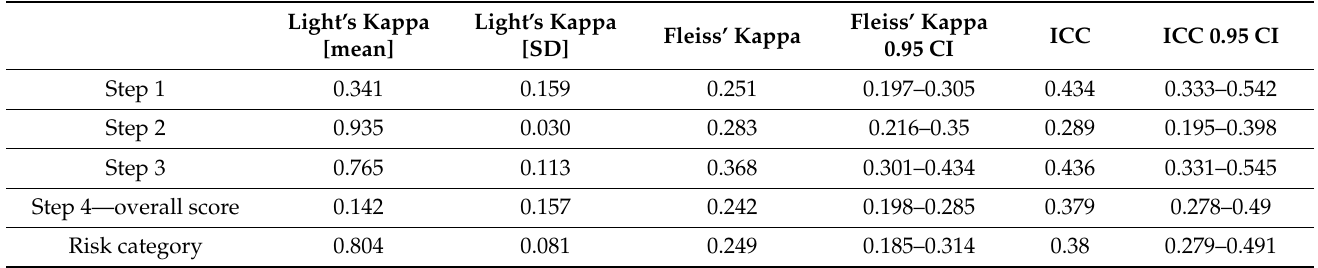
Table 3. Demographic results of the analysis of the total inter-rater variability for each step of the PRAETORIAN score